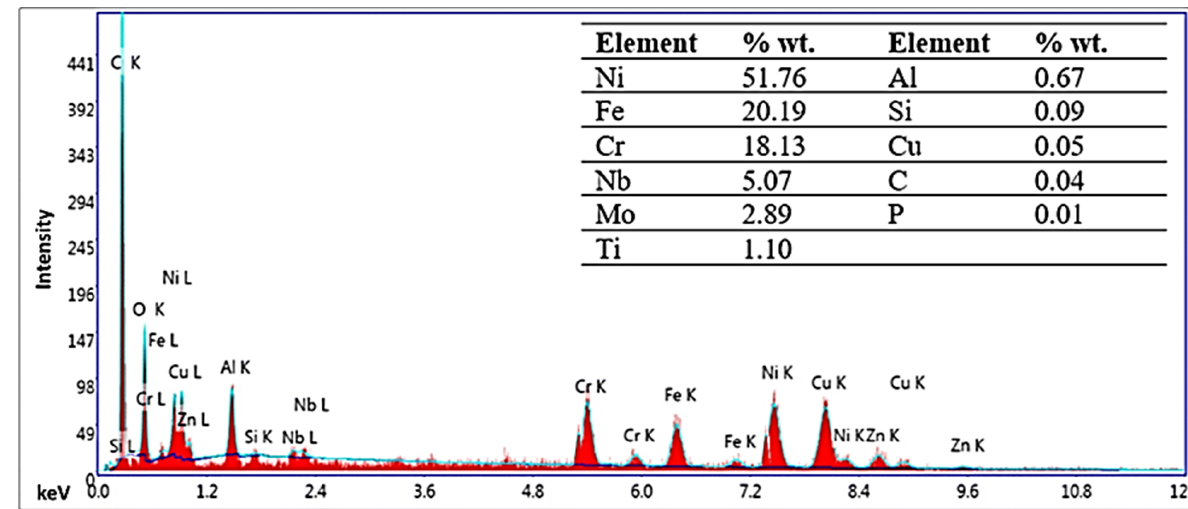
Figure 2. Energy-dispersive X-ray spectroscopy of the workpiece material, Inconel 718. Table 1. Physical properties of workpiece and wire electrode